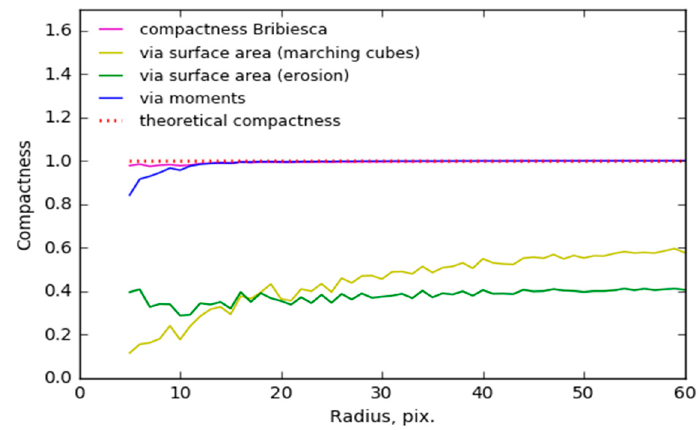
Figure 9. Compactness of spheres of different radii with a noisy surface.